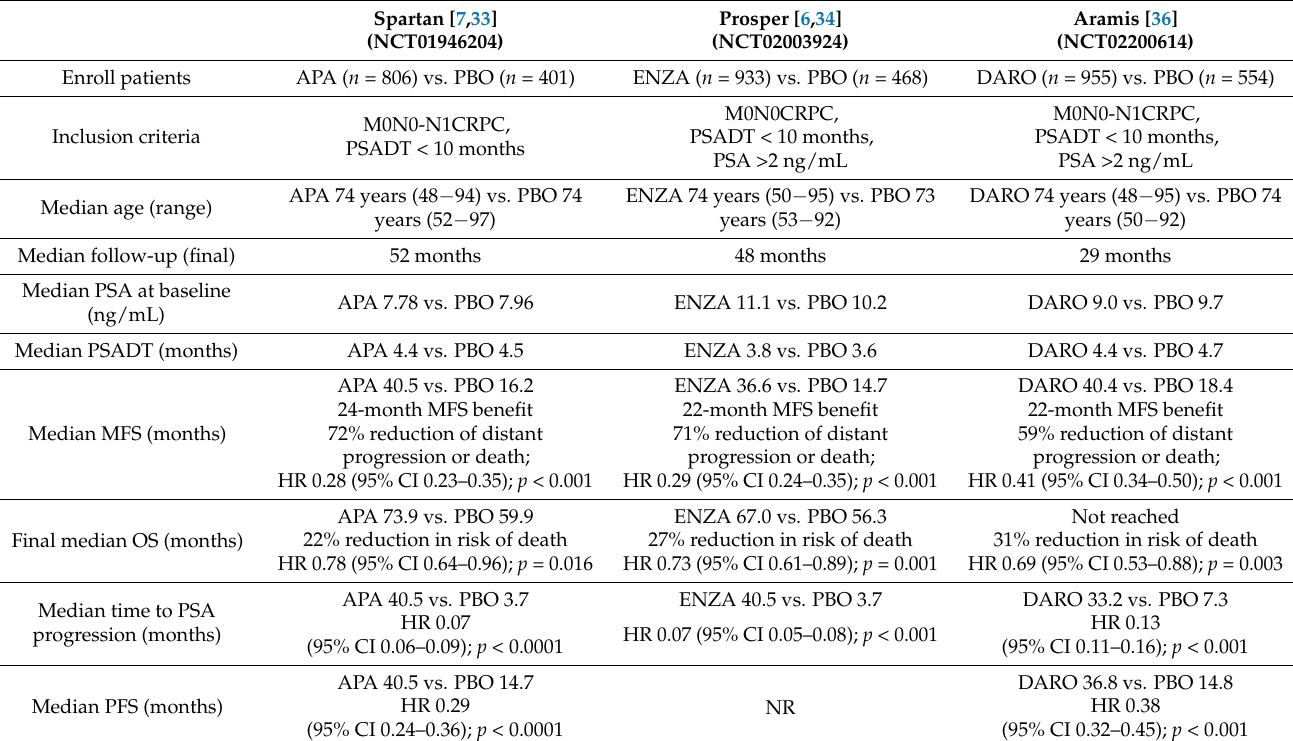
Table 2. Comparison of study populations and oncologic efficacy in nmCRPC treatment phase 3 clinical